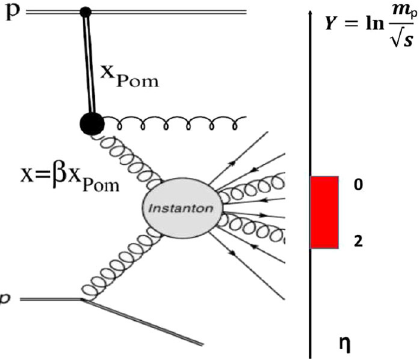
Fig. 1 Instanton production in a diffractive process with an LRG. The Pomeron exchange is shown by the thick doubled line. The red bar shows the range of η considered in this paper. Y indicates the incoming proton position in rapidity. As shown in the diagram secondaries will be produced also outside this range but they will not be used when calculating E T or N